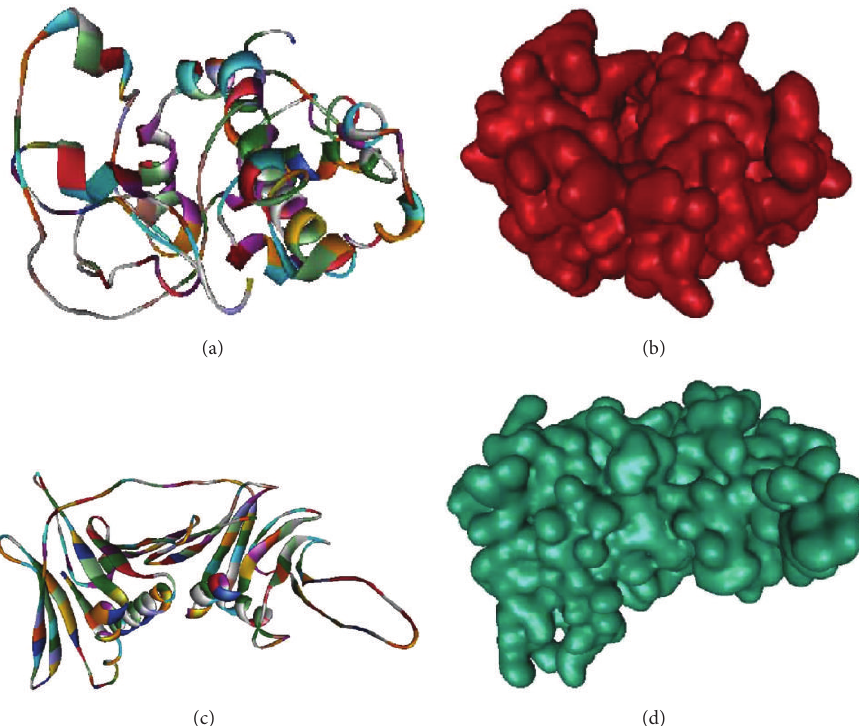
Figure 2: (a) Homology model of BCL-2 represented in solid ribbon pose, (b) BCL-2 model in surface representation, (c) RAD9 protein structure in solid ribbon pose, and (d) RAD9 protein structure in surface representation.